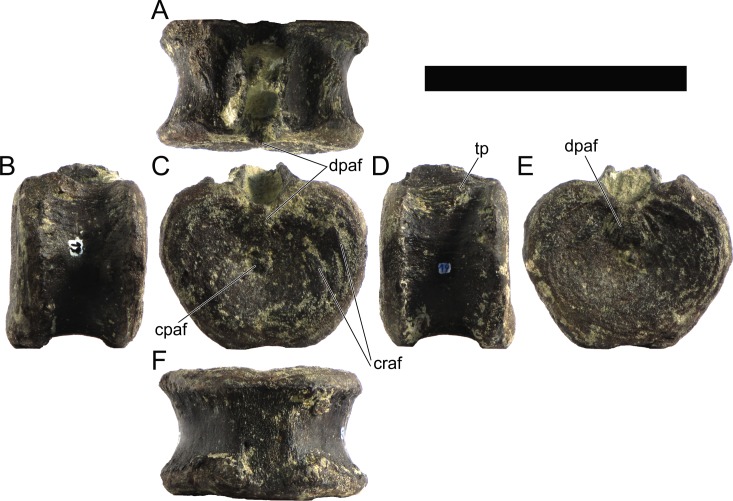
Caudal vertebra 28 of Miragaia longicollum MG 4863.A, dorsal, B, right lateral, C, anterior, D, left lateral, E, posterior, and F, ventral view. Cpaf, central process of articular facet, craf, concentric ridges of articular facet, dpaf, dorsal process of articular facet, tp, transverse process. Scale bar equal to 10 cm.